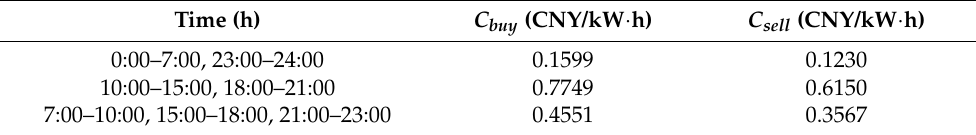
Table 5. Time-of-use prices.